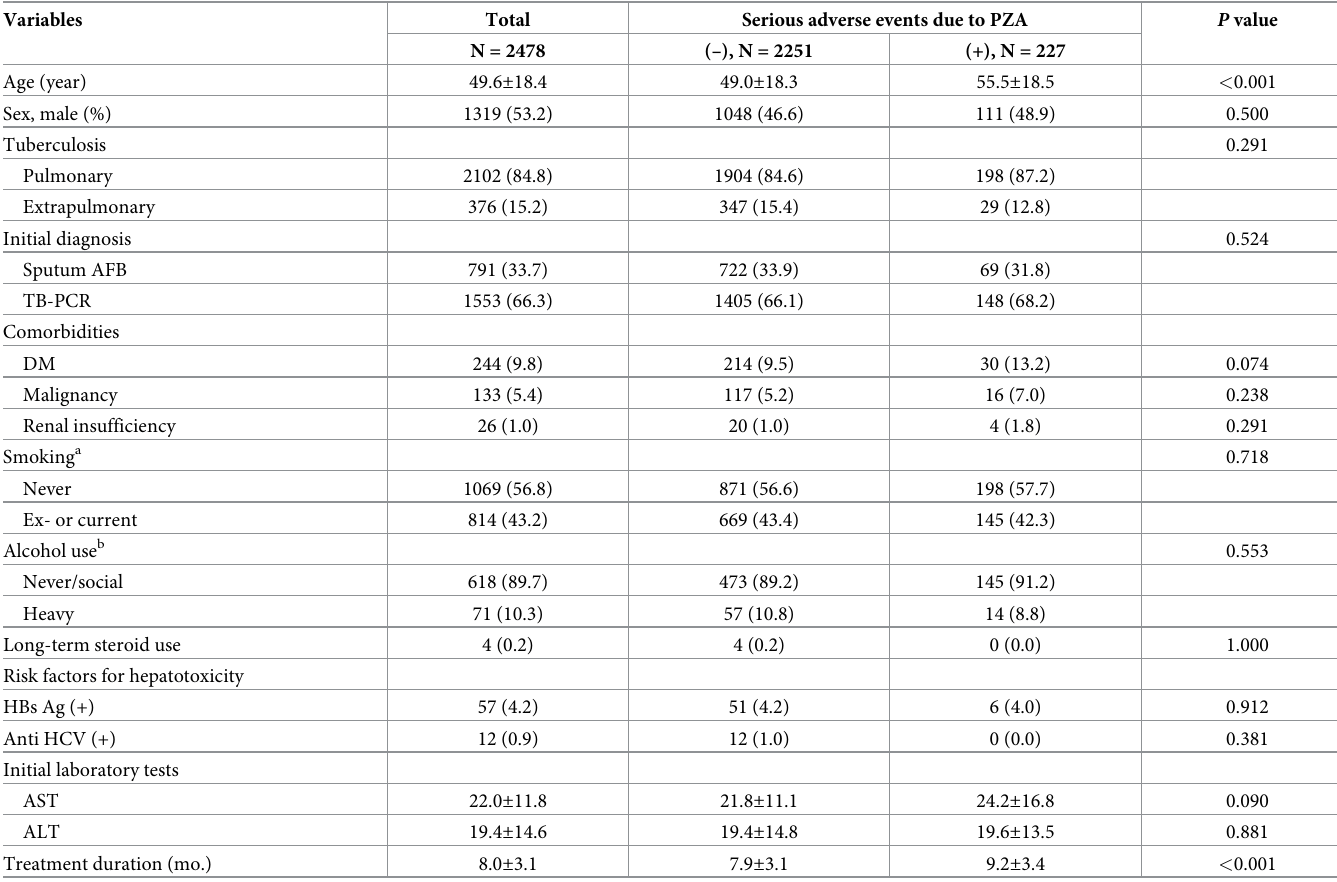
Treatment duration